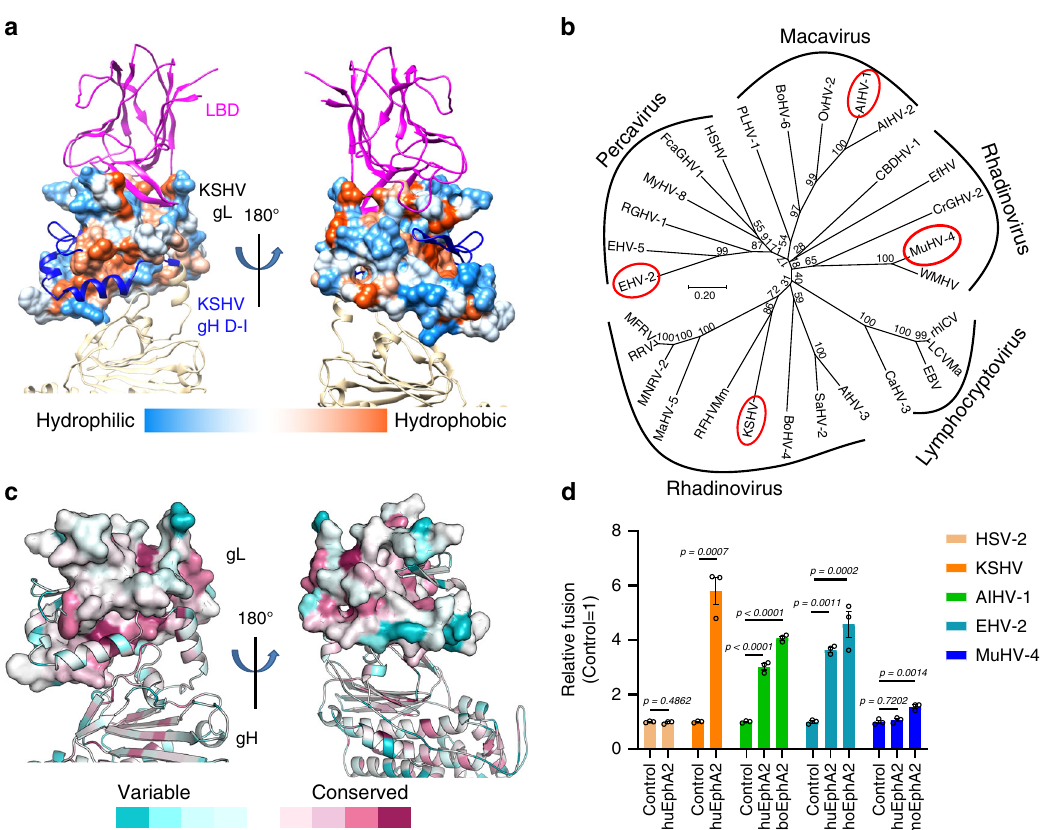
Fig. 6 EphA2 may serve as an entry receptor for multiple γ -herpesviruses. a The structure of KSHV gL shows hydrophobic (orange) surfaces on both the EphA2 and the gH-binding faces. Molecular surfaces are colored according to hydrophobicity, with blue, white, and orange corresponding to the most hydrophilic, neutral, and hydrophobic patches, respectively. b Phylogenetic analysis of the gL proteins from 29 γ -herpesviruses, as generated by MEGA 10.1 46 . Analyses were performed using the neighbor-joining method. The viruses selected for the cell fusion experiments are shown in red ellipses. c Conserved gL sequences mapped onto the protein surface. The gL surface is gradiently colored by the ConSurf server 47 , based on degree of conservation as indicated by the alignment of gL sequences from 29 γ -herpesviruses: the most conserved regions are dark magenta and the most divergent regions are dark cyan. d Cell-based fusion assays were performed by co-culturing of HEK-293T cells transfected with EphA2 and HEK-293T cells transfected with plasmids expressing viral gHgL and gB. The Macavirus AIHV-1, Percavirus EHV-2, and Rhadinovirus MuHV-4 were randomly selected for testing. KSHV was used as the positive control and HSV-2 was used as the negative control. Representative results from three experiments are shown. Relative fusion was normalized to the empty vector. The data are presented as mean ± SEM ( n = 3 independent replicates). Unpaired Student ’ s t -test was used for comparing two groups and ordinary one-way ANOVA with Dunnett ’ s multiple comparison test for multiple comparisons. boEphA2: bovine EphA2; hoEphA2: horse EphA2; huEphA2: human EphA2; moEphA2: mouse EphA2. The GenBank accession codes of gH, gL, and gB are shown in the Supplementary Table 3. Source data are provided as a Source Data fi